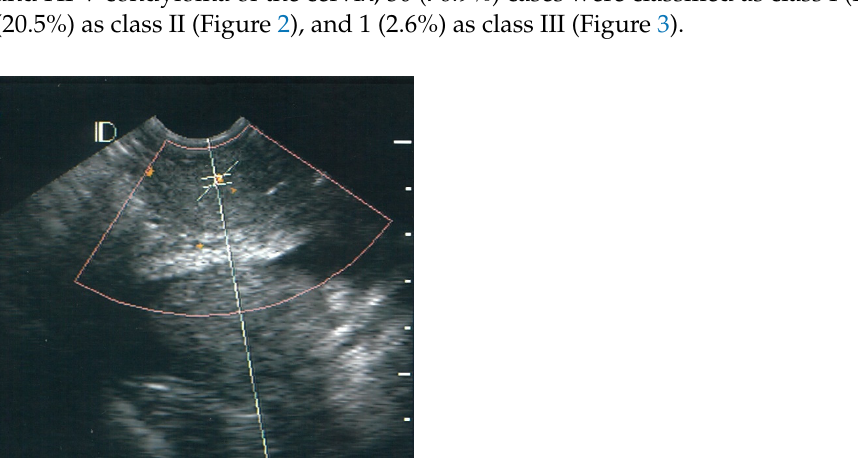
Figure 1. Example of Class I vascularity. There are three vascular hotspots with orange color representing the sagittal section of the uterine cervix area; each size is measured as about 1–2 mm.